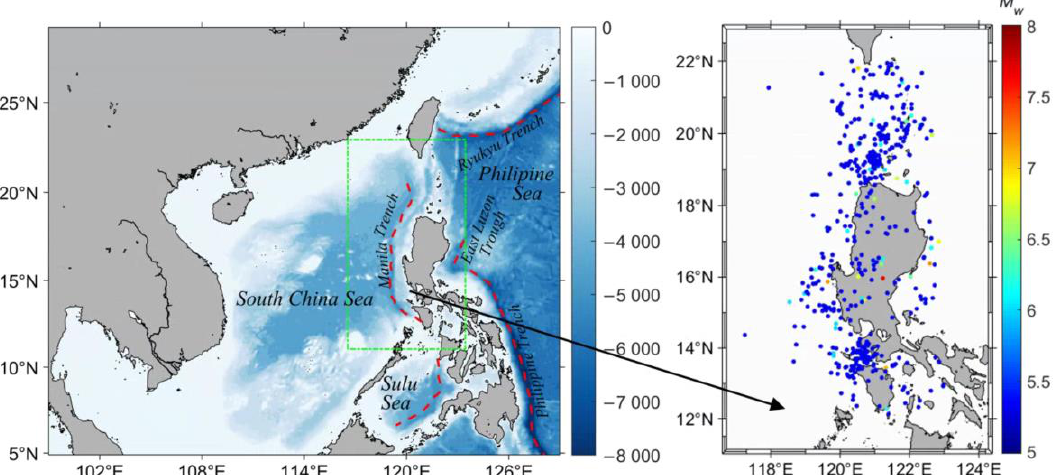
Figure 2. Map of study area. The right panel shows historical earthquakes around the Manila Trench based on GCMT (1977 – 2017), in which the color of dots shows the moment magnitude. based on GCMT (1977–2017), in which the color of dots shows the moment